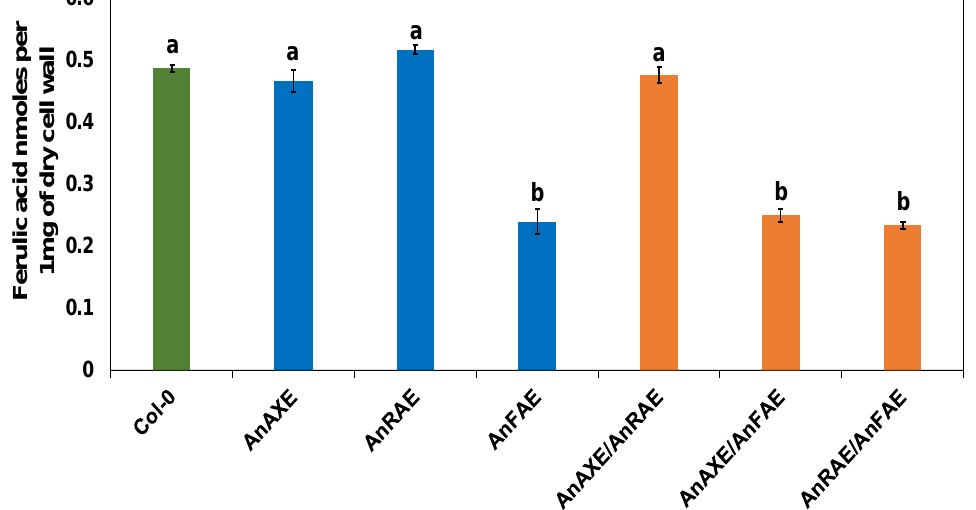
Figure 2. Cell wall feruloylation of transgenic and WT (Col-0) Arabidopsis plants. Ferulic acid content is represented in nmol per mg dry CW material. Data represent the average ± SD of three different independent transgenic lines of each construct and three WT plants. Letters (a and b) indicate significant differences among the genotypes (Fisher’s LSD test, p < 0.05). Among the single-gene overexpressing transgenic Arabidopsis plants, AnAXE and AnRAE plants showed resistance to the spread of fungal pathogens with a 29% and 32% reduction in lesion size, respectively, in comparison to Col-0 (Figure 3A). AnFAE Arabidop- sis plants were highly susceptible to B. cinerea, and the lesion size was 14% larger than the WT Arabidopsis. AnAXE/AnRAE Arabidopsis plants showed the highest resistance to the pathogen among all the plants with a 60% reduction in lesion size. AnAXE/AnFAE and AnRAE/AnFAE Arabidopsis plants were found to be susceptible to the pathogen at the same level as that of the WT Arabidopsis (Figure